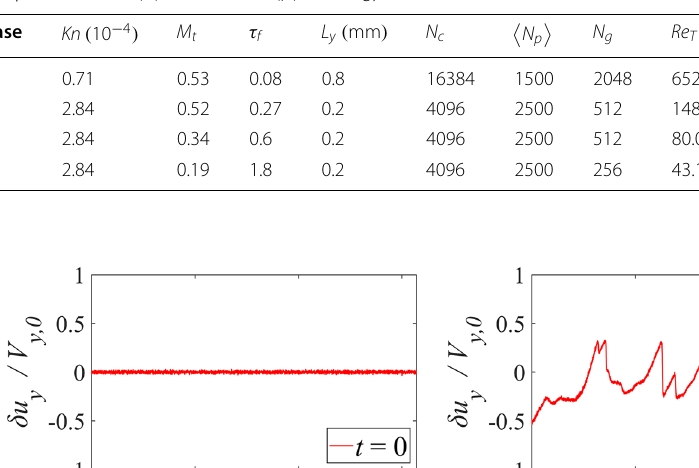
Table 2 Simulated parameters and flow statistics for 1D stationary turbulence. All the simulations are performed at